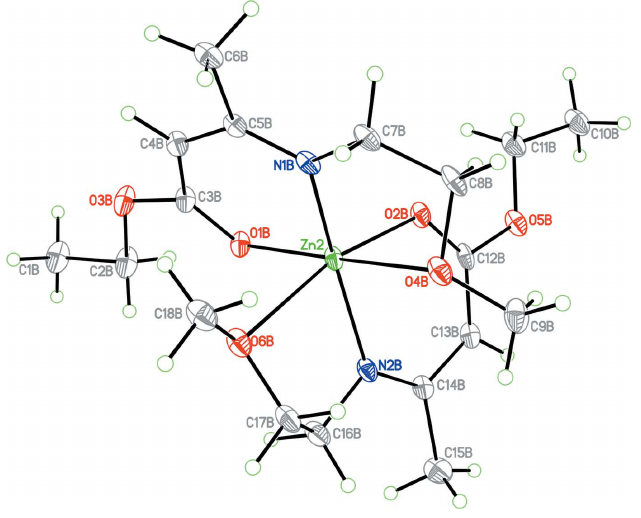
Figure 2 The molecular structure of molecule B (major disorder component only) showing long Zn—O (ether) bonds (arranged in a cis fashion) resulting a distorted octahedral coordination for the metal atom. Atomic displace- ment parameters are shown at the 30% probability